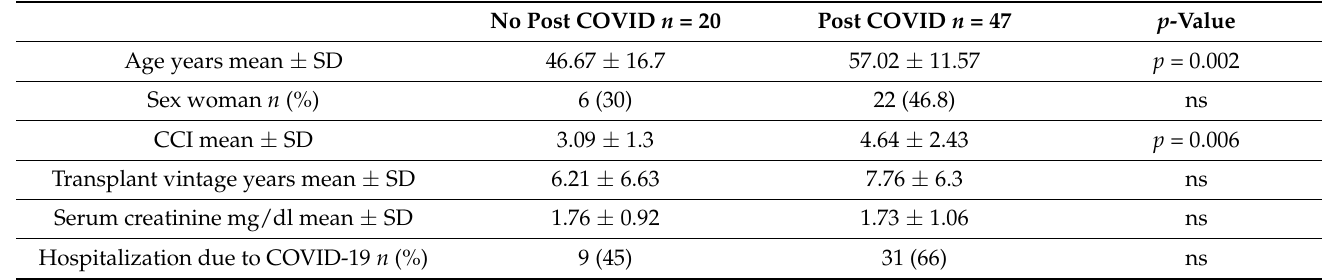
Table 2. Strata analyses of predictors for post-COVID syndrome